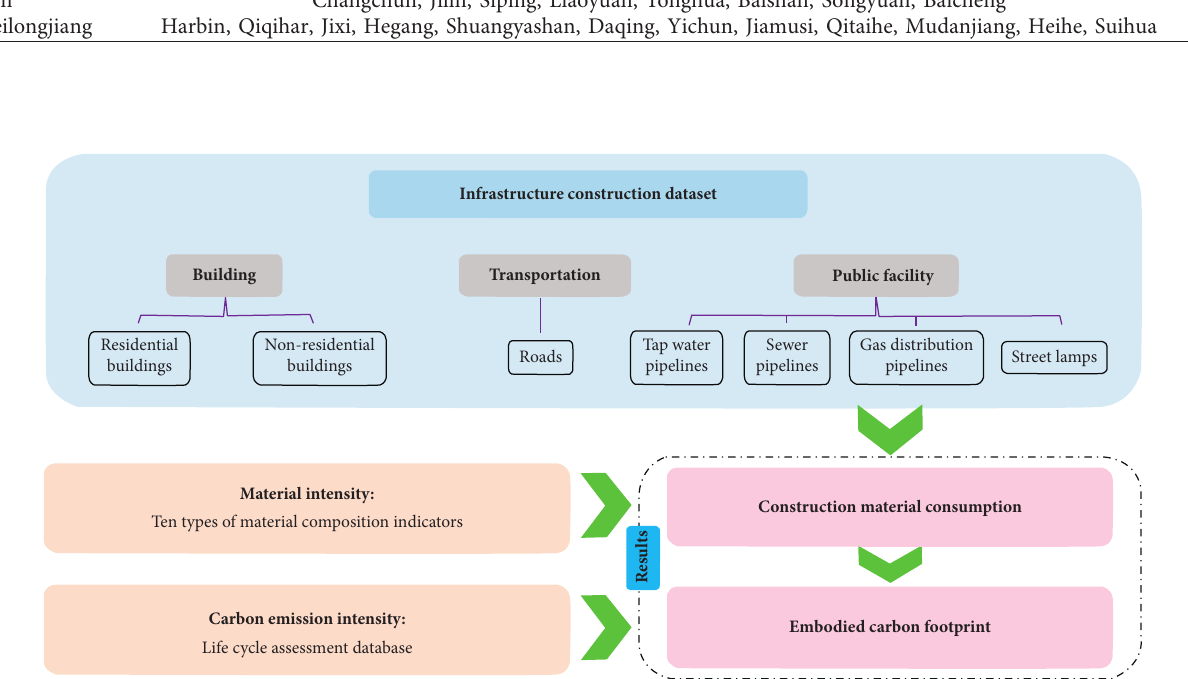
Table 2: Cities within each of the three provinces of Northeast China examined in this study. Provinces Prefecture-level cities covered Liaoning